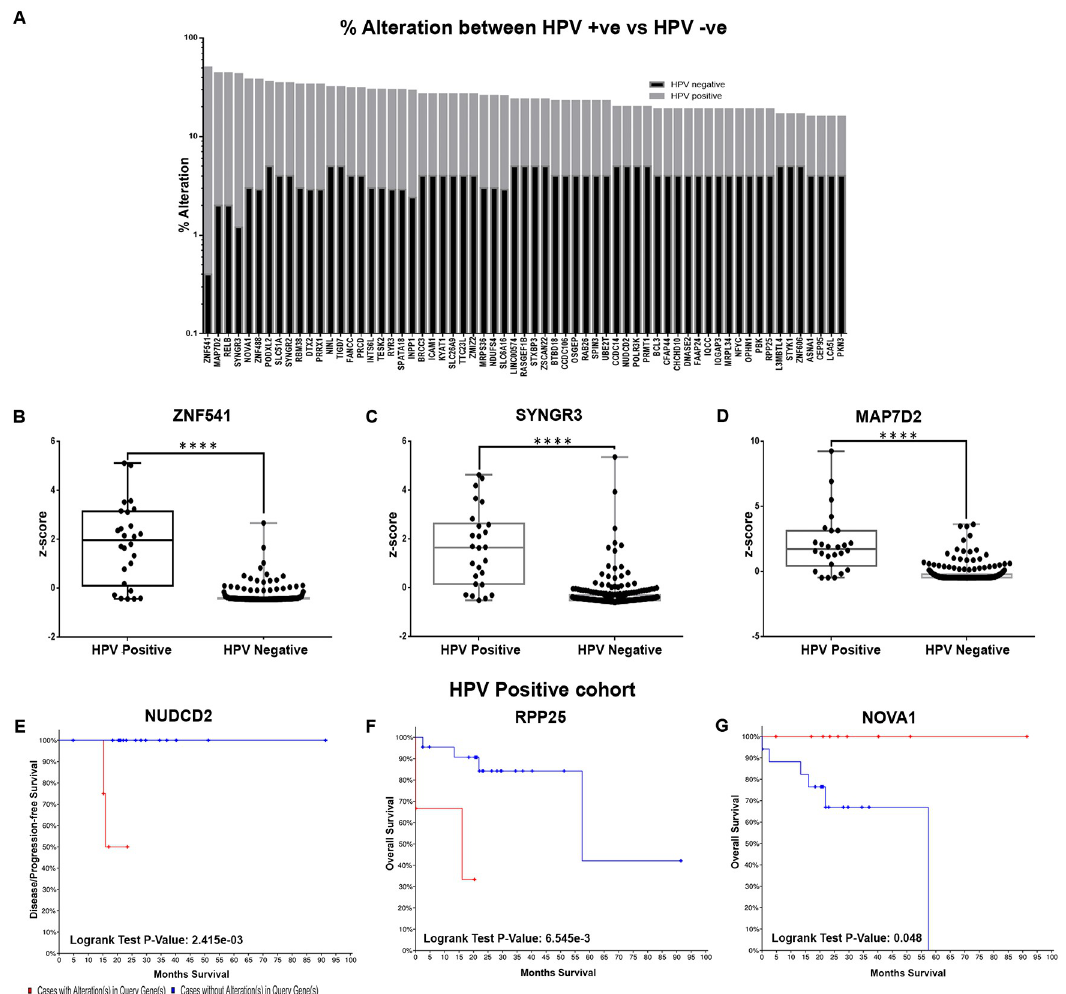
Fig 2. Marker profile in HPV+ HNSCC in terms of alterations, differential expression and prognostic efficacy. Comparison of the significant gene entities across HPV positive and negative cohort for their percentage alteration identified a total of 63 genes as highly altered in HPV positive cohort as compared to HPV negative cohort (A) . Assessment of expression levels (mRNA z-score) indicated that all these genes were significant differentials (p < 0.05) between the two cohorts; the profile of top 3 genes (both alterations and z-score); ZNF541 (50%), SYNGR3 (42%), MAP7D2 (42%) in HPV positive TCGA cohort is represented as boxplots. (B-D) . The selected markers (n = 63) were analysed for their significant association with disease free and overall survival in patients with HPV positive cancer in TCGA. KM analysis indicated that NUDCD2 ( E ) was associated with DFS (p = 2.415e-03), RPP25 ( F ; p = 6.545e-3) and NOVA1 ( G ; good prognosticator, p = 0.048) were associated with OS. (P-value; ���� p <